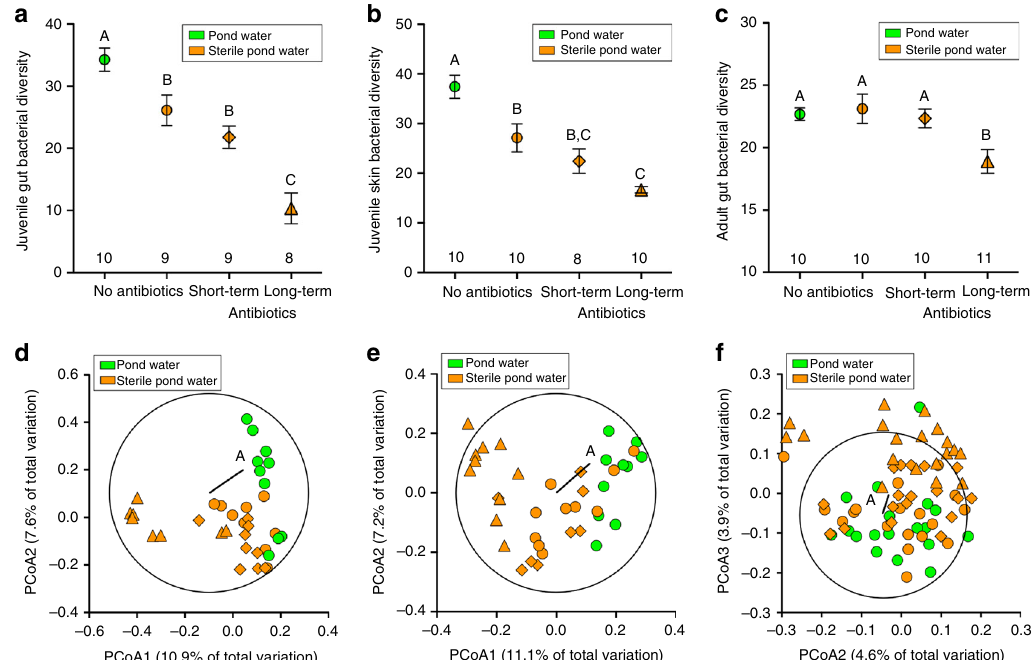
Fig. 2 Effect of early-life microbiota disruption on juvenile and adult bacterial diversity and community membership. a – c Mean alpha Faith ’ s bacterial diversity (phylogenetic diversity metric) across water treatments for samples from a juvenile guts (GLM, χ 2 = 62.99, df = 3, P < 0.0001), b juvenile skin ( χ 2 = 49.96, df = 3, P < 0.0001), and c adult guts (GLMM, χ 2 = 13.86, df = 3, P = 0.003). Error bars indicate the s.e.m. Numbers above the tick marks on the x -axis are the number of replicates (tanks) per treatment, and treatments that do not share letters above the error bars are signi fi cantly different based on a sequential Bonferroni post hoc multiple comparison test ( P < 0.05). d – f Effect of water treatment on bacterial community membership from d juvenile guts (PERMANOVA, F 3,35 = 2.43, P = 0.001), ( e ) juvenile skin ( F 3,37 = 2.35, P = 0.001), and f adult guts ( F 3,76 = 1.42, P = 0.001). Principal coordinates analyses (PCoA) were based on unweighted UniFrac scores. Vector A represents the direction and strength of the correlation between water treatment and relative abundance of phylum Fusobacteria and the circles represent a unit circle (radius = 1) to indicate the direction and correlational strength of vector A. For all panels, different shapes (antibiotic exposure) and colors (water treatment exposure) represent the different water treatments: pond water ( green circles ), sterile pond water only ( orange circles ), sterile pond water and short-term antibiotic water ( orange diamonds ), and sterile pond water and long-term antibiotic water ( orange triangles